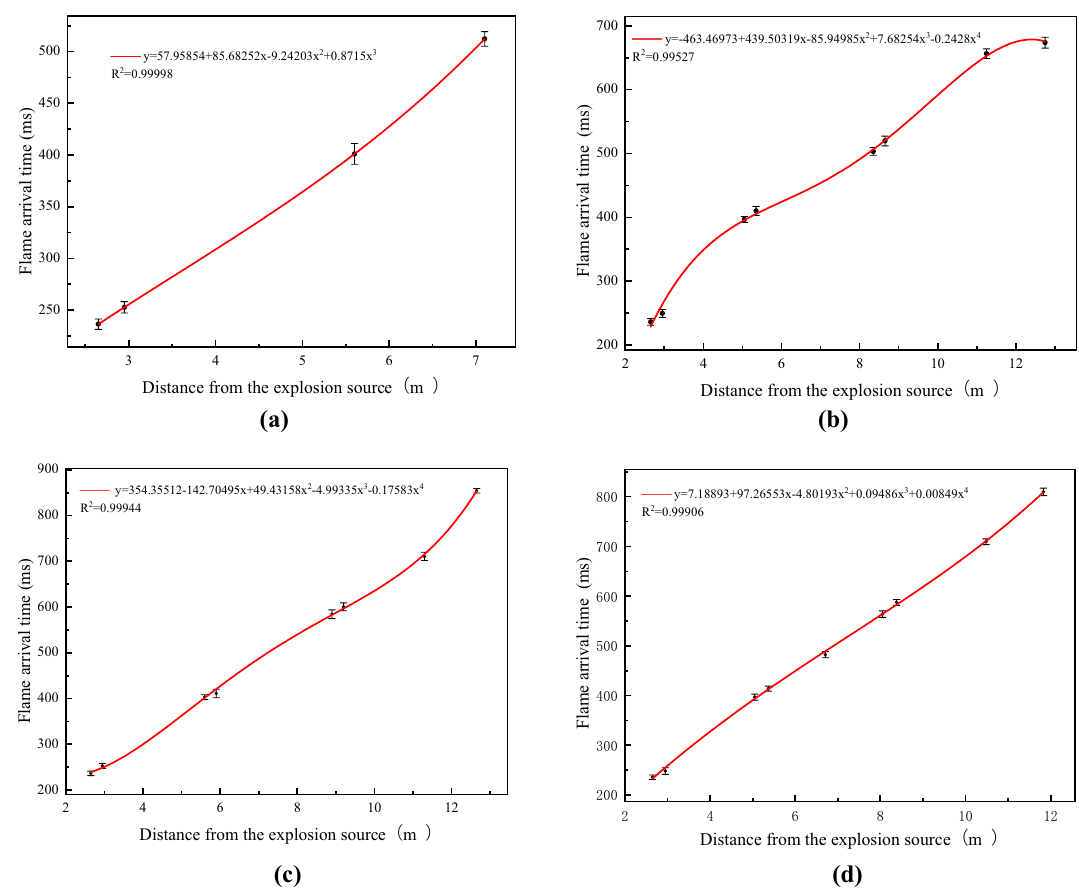
Figure 7. Flame arrival time for 20%. ( a ) O–A–B–C branch; ( b ) O–A–D–F–H–G branch; ( c ) O–A–B–E–H–G branch; ( d ) O–A–D–E–H–G